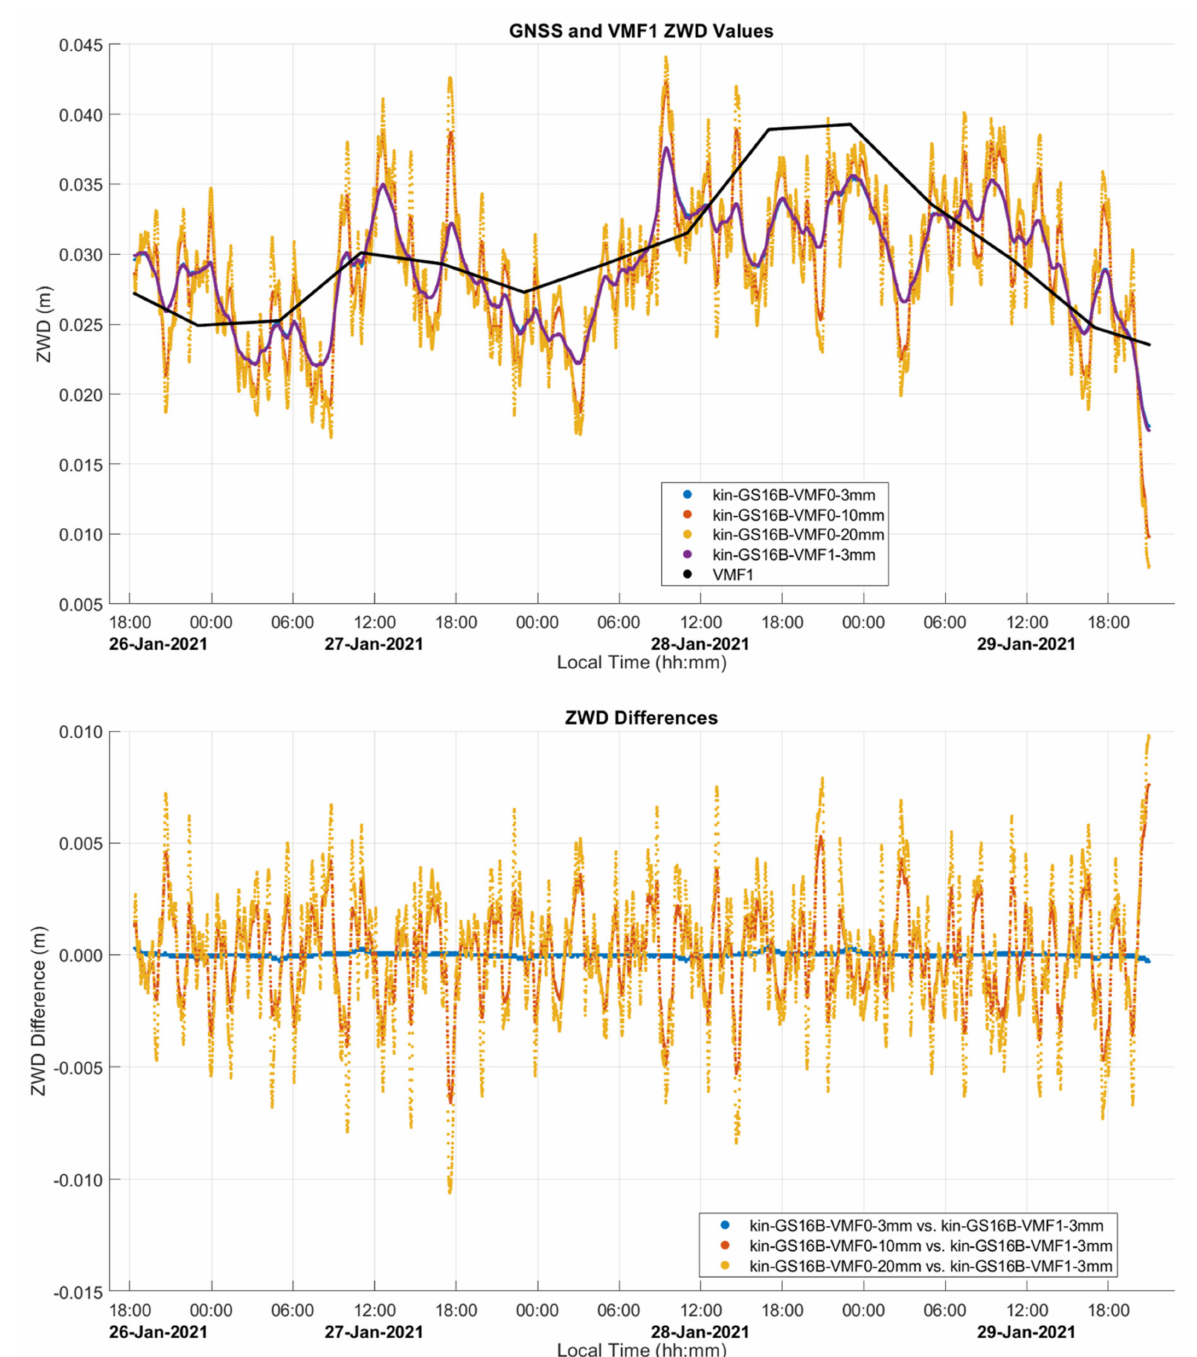
Figure 18. Static dataset A GS16B receiver comparison of PPP ZWD profiles using the VMF1 model in the online software versus a value of 0 with different process noise (upper plot) and differences with respect to online solution (lower